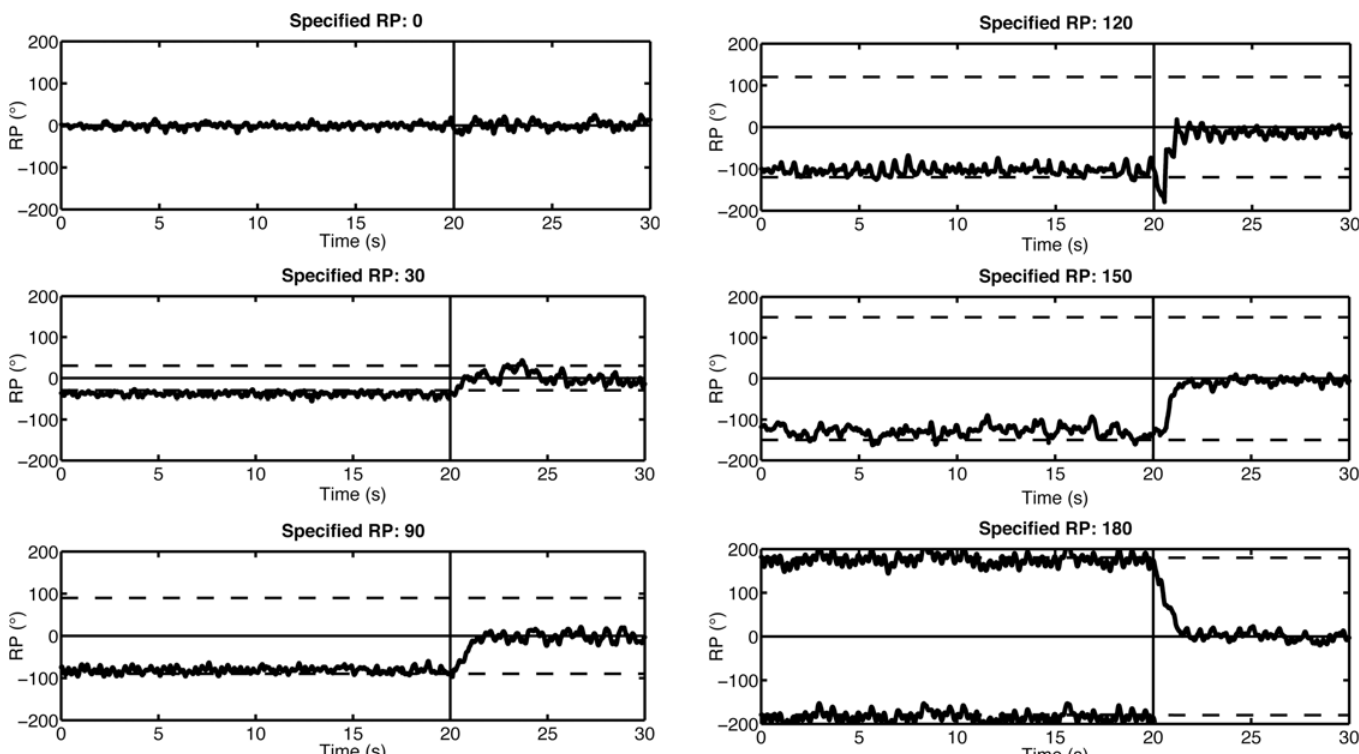
Fig 3. Individual data at scanning. Individual data showing the produced RP (in°) as a function of time in six scanning trials. Each panel pertains to a pattern specified by the VT (RP = {0, 30, 90, 120, 150, 180°}); dotted lines represent the specified RP. The vertical bar in each panel denotes the end of the Exposition and the beginning of the Memory